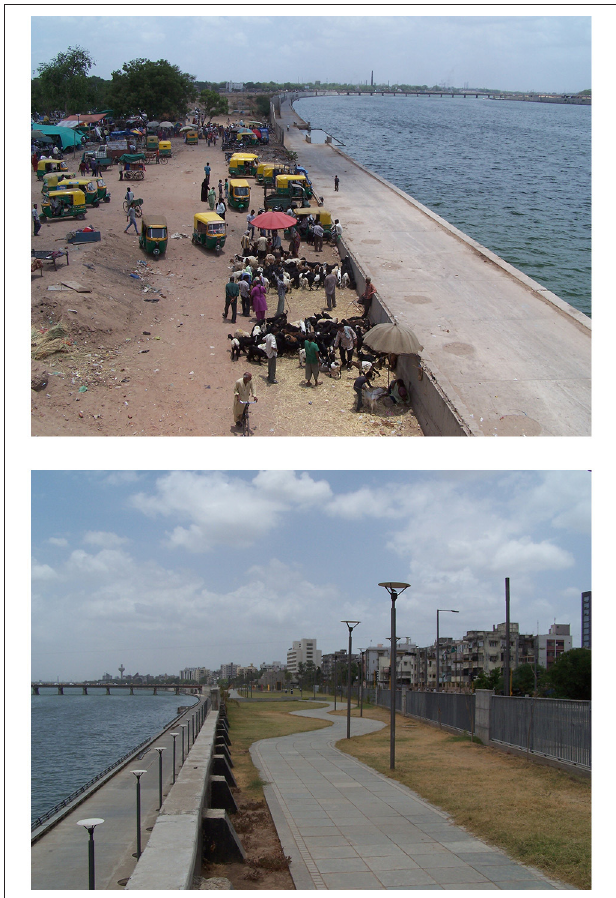
FIGURE 4 | Sabarmati Riverfront,